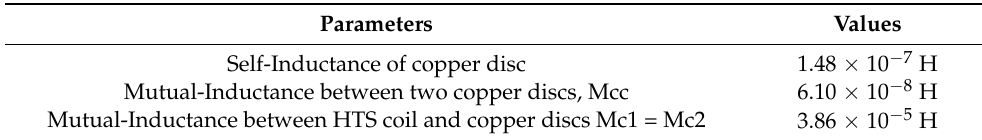
Table 3. The inductance